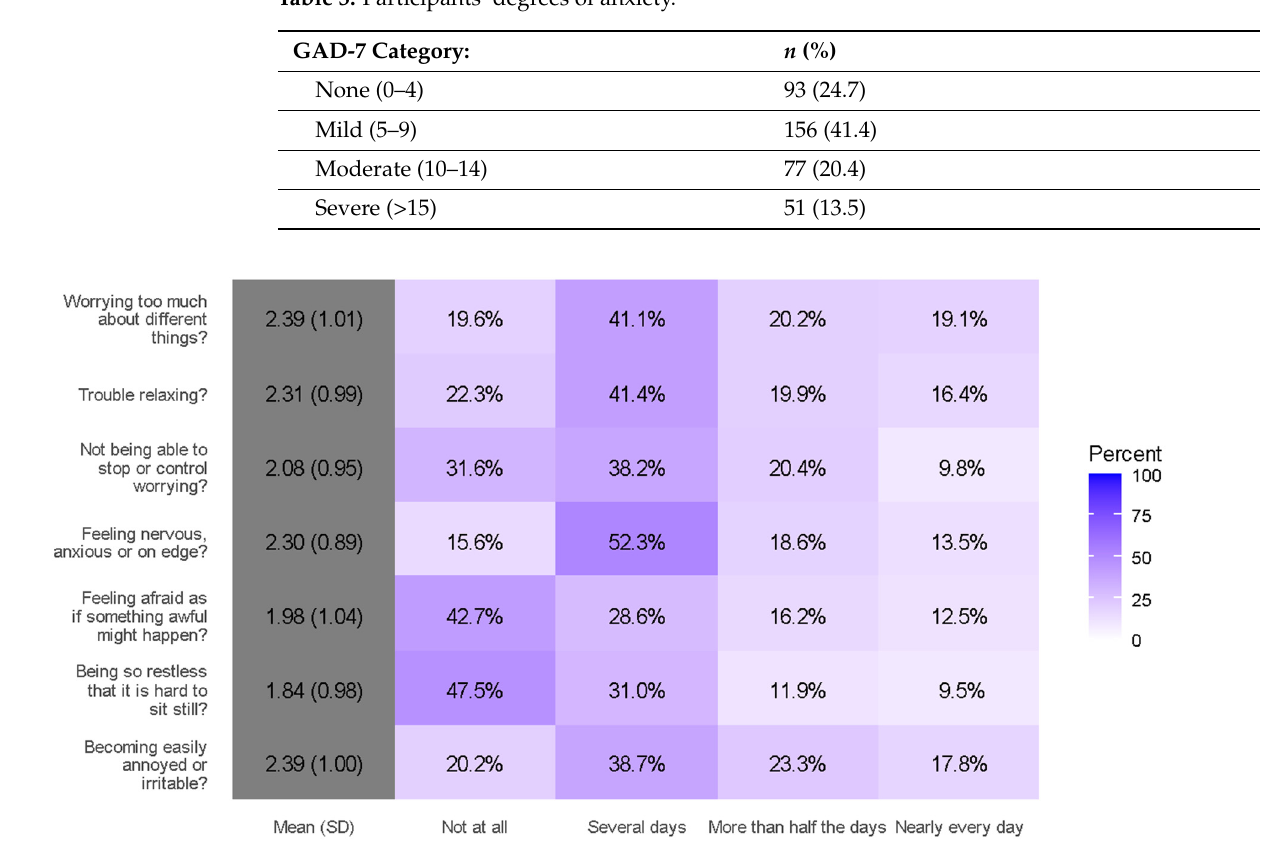
Table 3. Participants’ degrees of anxiety.